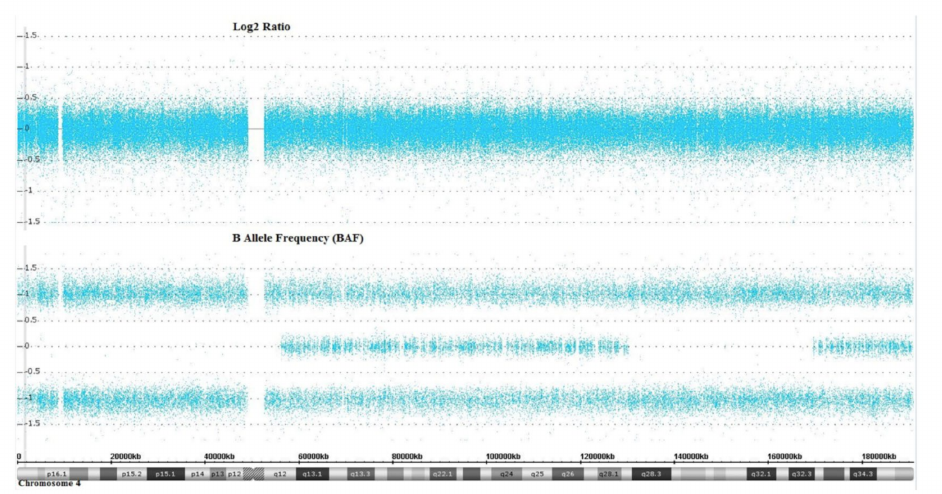
Figure 2. SNP-arrays identified the presence of a segmental UPD on chromosome 4. The log2 ratio indicates a normalized intensity value of each SNP across chromosome 4 compared to diploid individ- uals. In detail, the log2 ratio of 0 indicates the absence of copy number alterations (i.e., microdeletions and/or microduplications) on chromosome 4 in our patient compared to controls. The B allele can have values of 1 (BB), 0 (AB) and − 1 (AA) in a diploid individual. Data show that the patient had a segmental UPD spanning the chromosome 4p and 4q regions. In detail, the B allele frequency shows a 56.1-Mb loss of heterozygosity at chromosome 4p16.3q12 (46,690-56,195,626; hg19), and a 39.4-Mb loss of heterozygosity at chromosome 4q28.2q32.3 (130,191,096-169,630,204; hg19). Genotype analysis confirmed an allelic imbalance compatible with maternal chromosome 4p16.3q12 and 4q28.2q32.3 UPD (data not